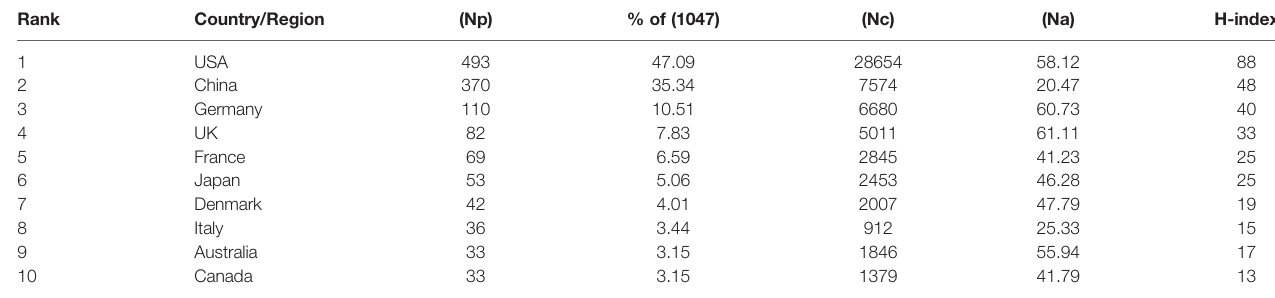
TABLE 1 | Publications in the 10 most productive countries/regions.